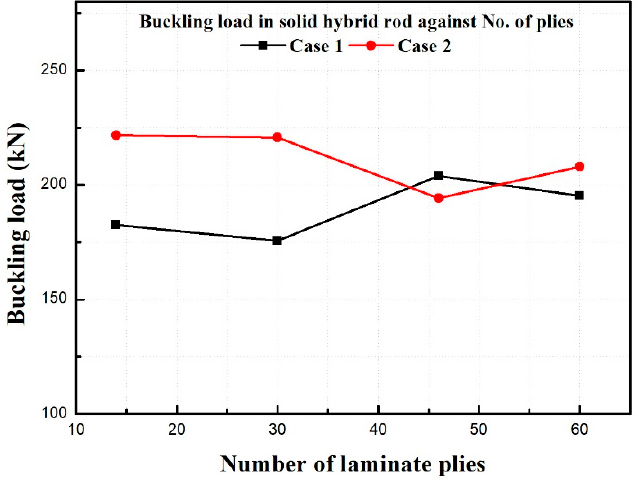
Figure 11. Variation of buckling load in hybrid rod with respect to No. of laminate plies in CFRP.